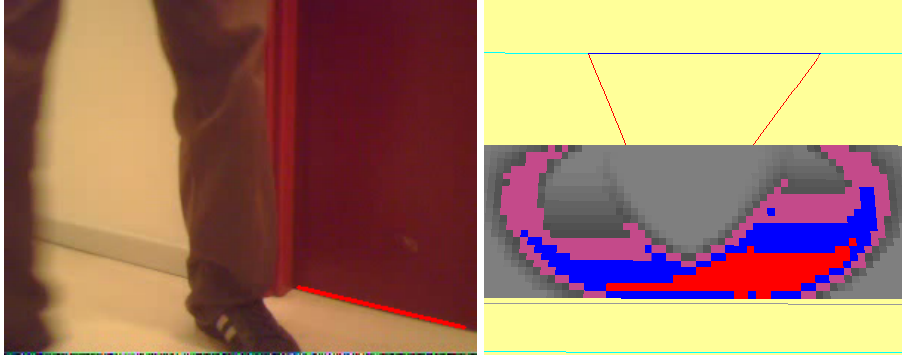
Figure 26. Observed image (left) and calculated probabilities with occlusions for any theta (right).